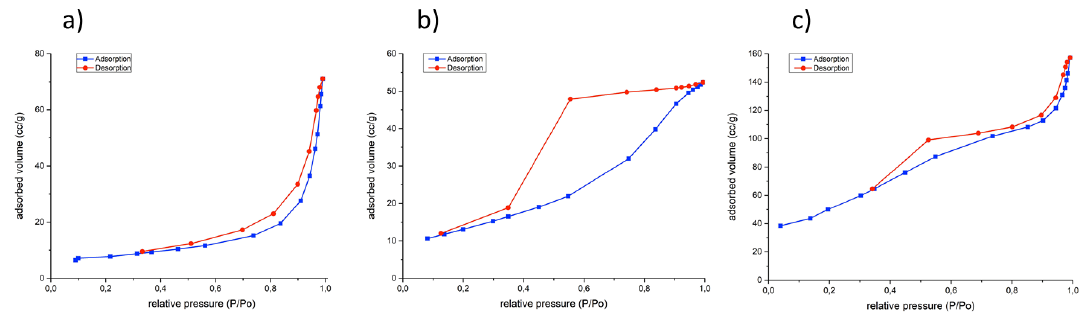
Figure 4. N 2 adsorption-desorption isotherms for samples: ( a ) HTMgAl1, ( b ) HTNiMgAl1 and ( c ) HTCuZnCr. 224